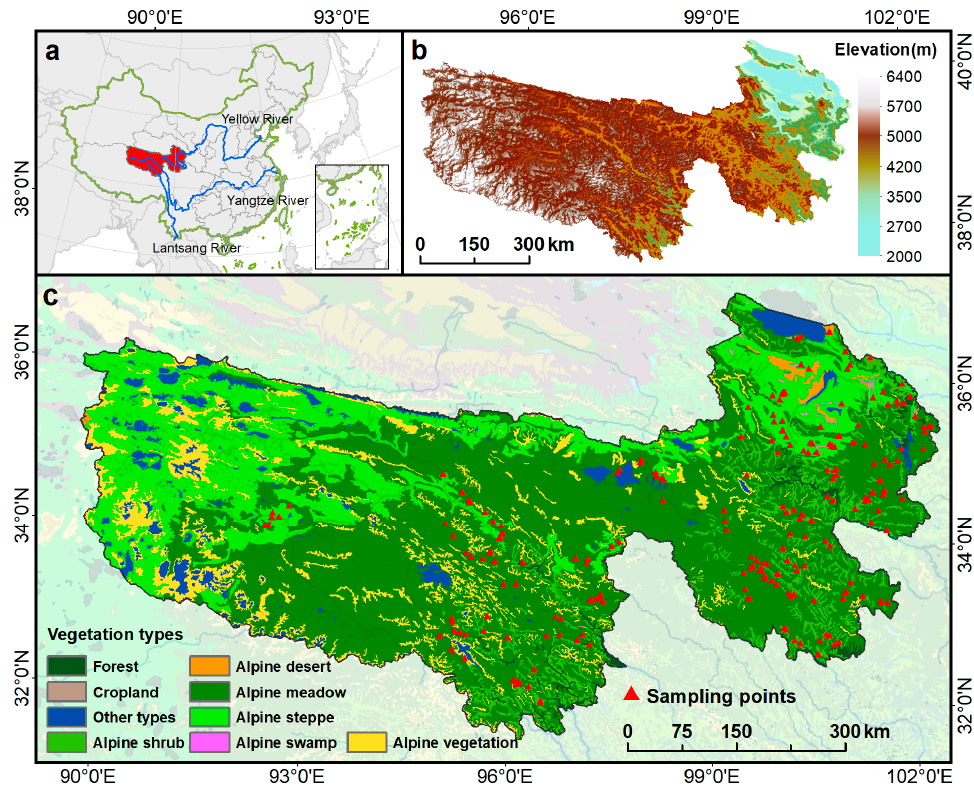
Figure 1. Location of the study area and vegetation types. Study area, including the Three-River Headwaters (TRH) region: ( a ) location relative to China, ( b ) elevation, and ( c ) vegetation types.